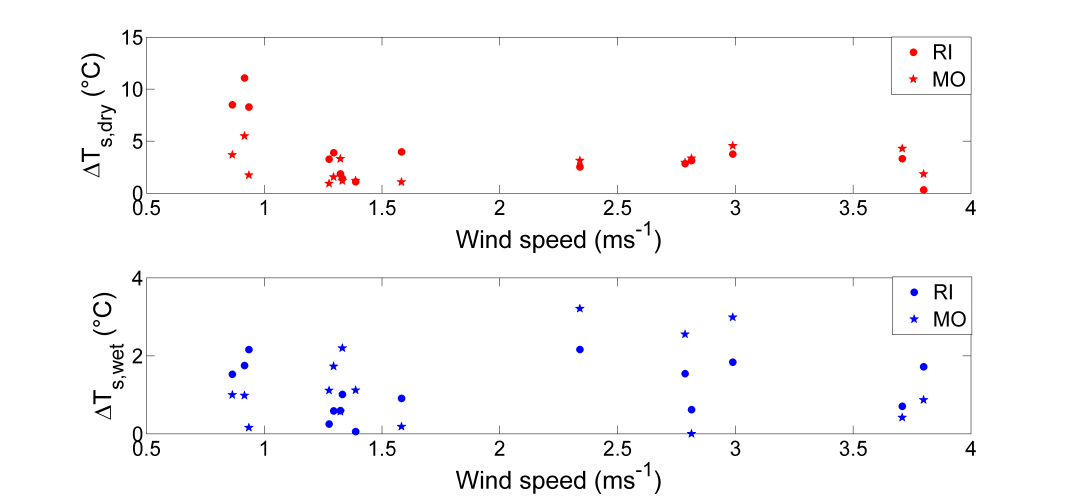
Figure 8. Absolute value of the simulated to observed maximum ( top ) and minimum ( bottom ) soil temperature difference as a function of wind speed for the RI and MO aerodynamic resistance separately.